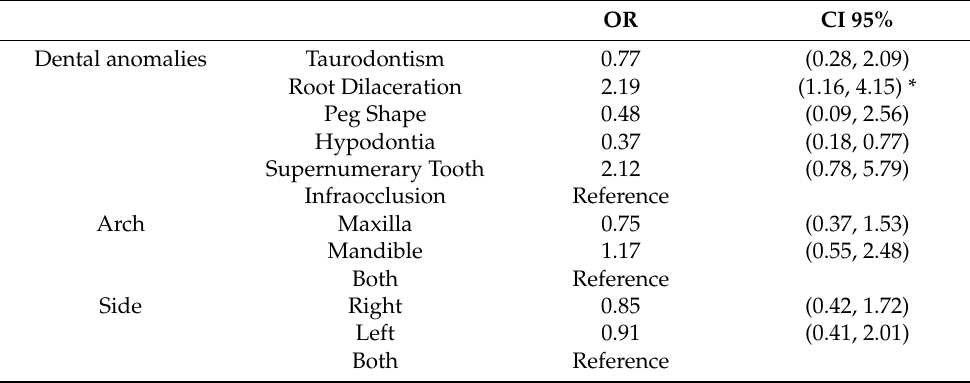
Table 5. Ordinal logistic regression with sex as the outcome variable and dental anomalies, arch and side being the explanatory variables ( n = 161).